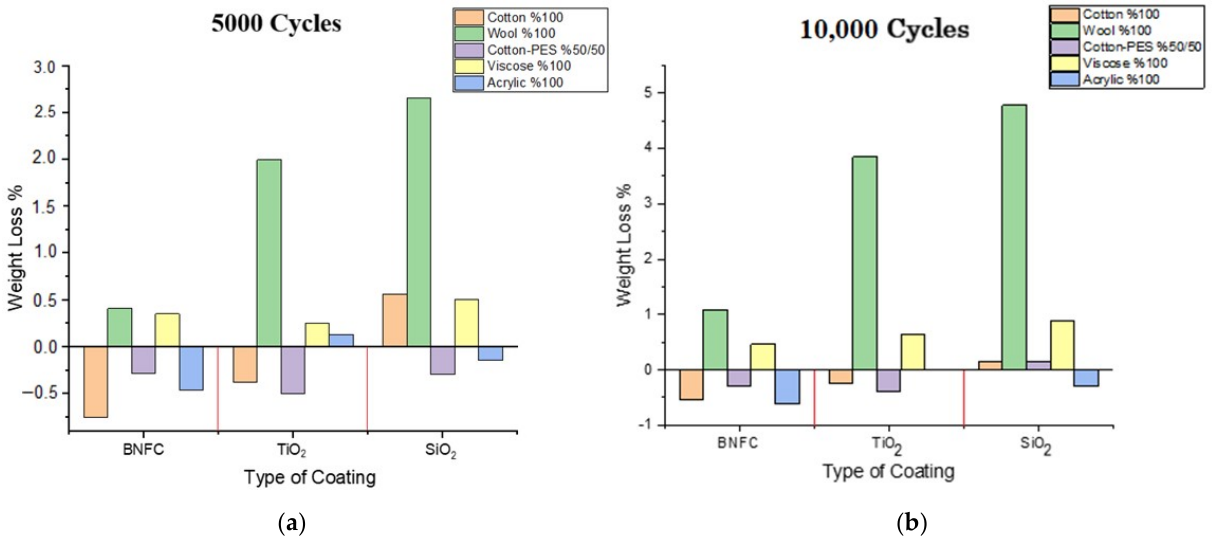
Figure 3. Percent weight loss: ( a ) after 5000 cycles; ( b ) after 10,000 cycles.